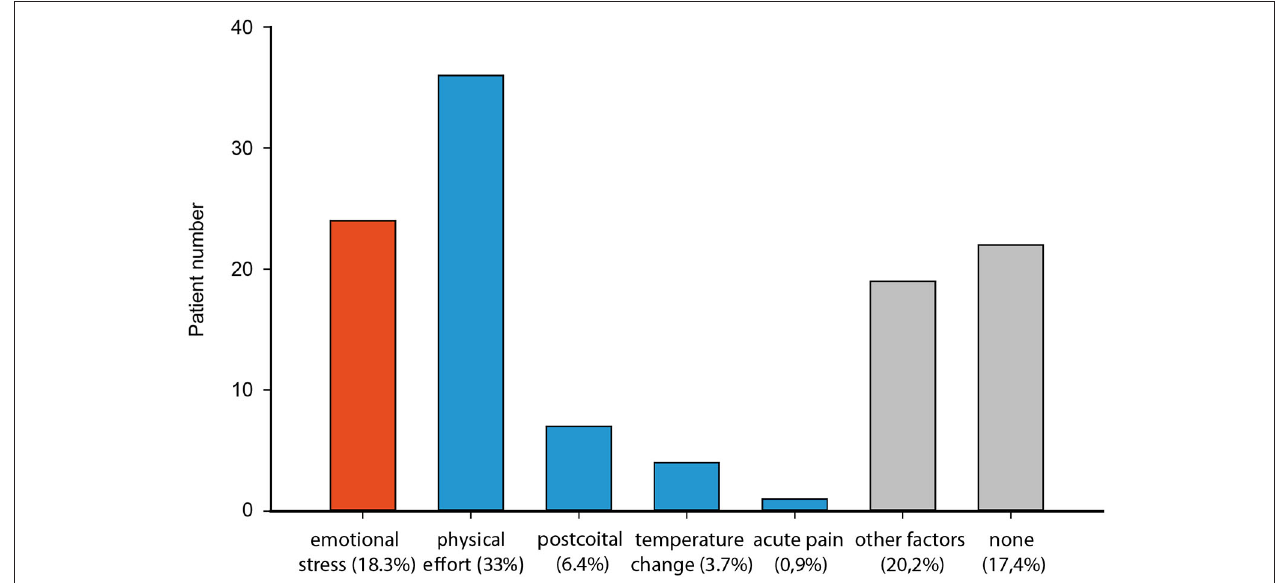
FIGURE 1 | Distribution of precipitating events of 113 patients with a TGA classified as emotional stress (red) and physical (blue) (physical effort, postcoital, temperature changes, acute pain) and others (grey) .